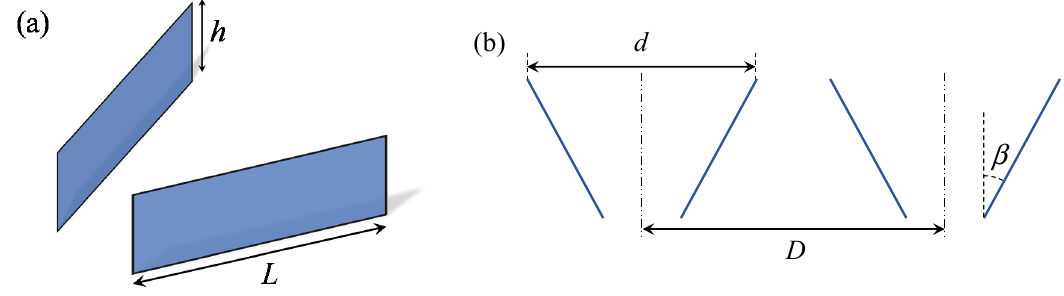
Figure 2. Schematic of the rectangular vane-type vortex generators in a counter-rotating configuration. ( a ) Isometric view; ( b ) planar view.